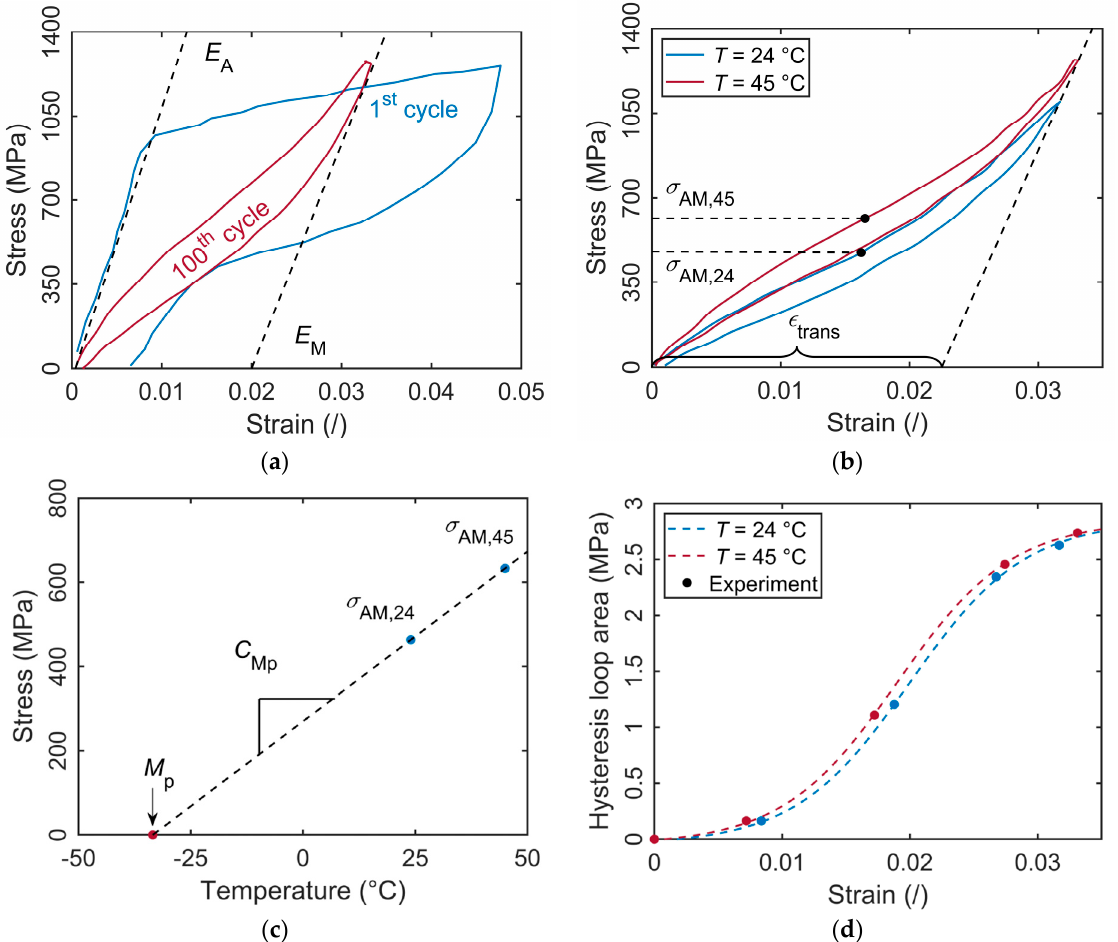
Figure 2. The first and last training cycles and determination of E A and E M ( a ); isothermal superelastic stress-strain behavior at 24 °C and 45 °C and determination of transformation strain and critical stress at the middle of the transformation ( b ); the phase diagram for the forward transformation showing the martensite peak temperature and the corresponding Clausius-Clapeyron coefficient ( c ); and the isothermal hysteresis loop area as a function of strain for both evaluated temperatures ( d ).